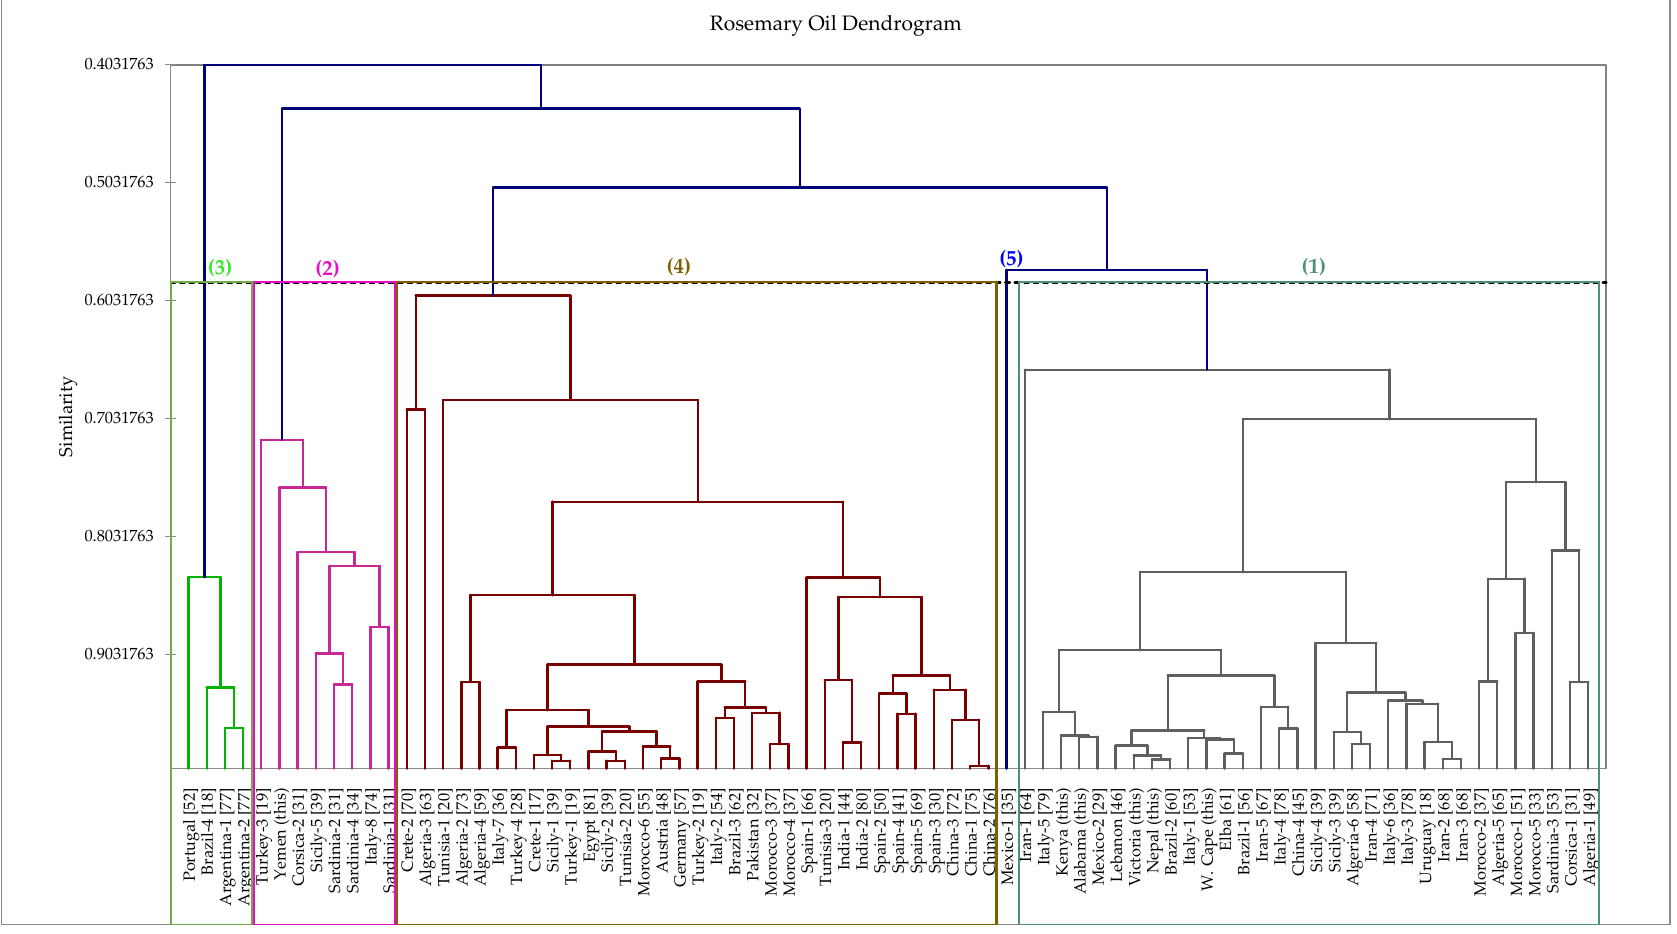
Figure 1. Dendrogram obtained from the agglomerative hierarchical cluster analysis of 78 Rosmarinus officinalis essential oil compositions